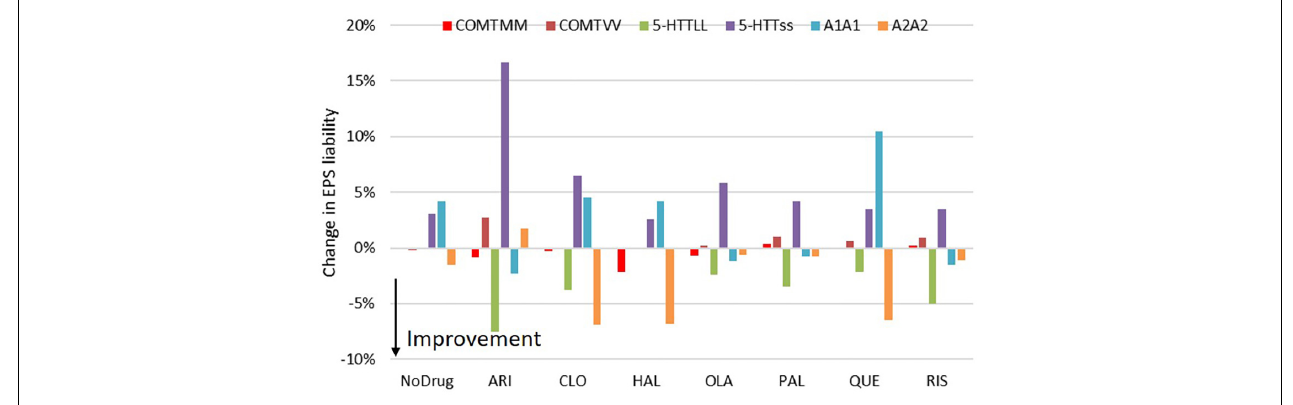
FIGURE 3 | Effect of COMT, 5-HTTLPR rs25531 and D2DRTaq1 genotypes on the EPS liability for the different antipsychotics. The figure shows the changes in probability for patients needing anticholinergic mediation to address their motor side-effects (for instance MM/*/* and VV/*/*) vs. the heterozygote subjects (for instance MV/*/*). All results are averaged over the 9 possible combinations of the other two genotypes with the appropriate distribution depending upon the frequency of the genotypes. While the COMT genotype has no effect on EPS liability, both the 5-HTTLPR and DRD2Taq1 alleles affect this side-effect substantially. The */LL/* genotype, by virtue of its lower 5-HT tone, acts as a 5-HT 2 A antagonism mechanism; while the */*/A2A2 genotype has a higher dopamine D 2 R expression which effectively acts as less D 2 antagonism.